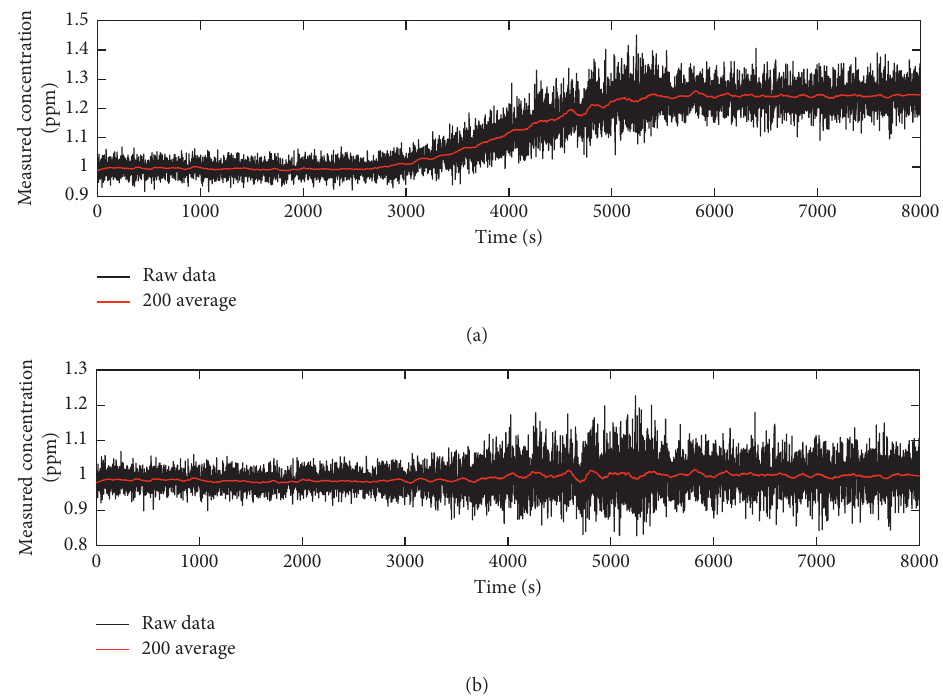
Figure 11: Comparison of detection results of 1ppm methane standard gas using the traditional method and differential measurement